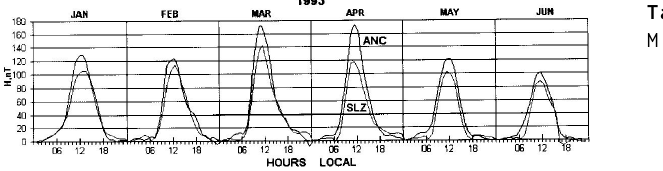
Fig. 1a. Monthly mean variations of the daily range in H for five international quiet days at ANC and SLZ for the months January to June 1993.